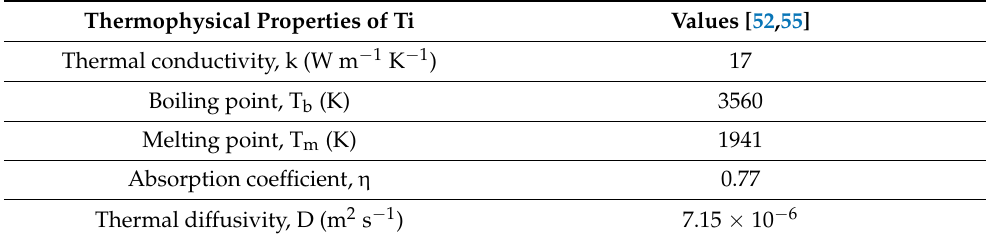
Table 1. Thermophysical properties of titanium. Thermophysical Properties of